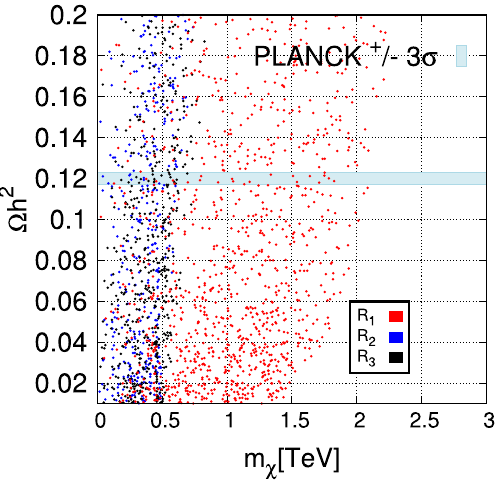
Fig. 7 Relic density as a function of the DM candidate mass. R i sce- narios are described in the main text